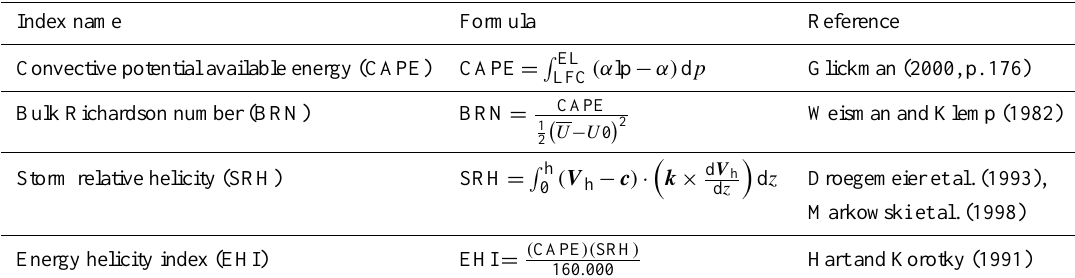
Table 1. A selection of indices commonly used for severe storm forecasting. In the formulae, T denotes temperature and D denotes dew point in ◦ C, with a subscript indicating at what mandatory pressure level (in hPa) this value is to be taken from; α denotes the specific volume and lp denotes a value associated with a lifted parcel; LFC stands for a lifted parcel’s level of free convection and EL stands for its equilibrium level. For the Bulk Richardson number, U 0 denotes the density-weighted speed of the mean vector wind in the layer 0–6km, and U denotes the speed of the mean vector wind in the layer from the surface to 500m – the quantity is sometimes referred to as the “BRN shear”. For the storm-relative helicity, k × d V h is the horizontal vorticity, and vector k is the unit vector in the vertical, V h − c is the storm-relative d z environmental wind velocity. The shear vector consists of two components, the speed shear V h (a change in wind speed with height) and the directional shear or storm motion vector (a change in wind direction with